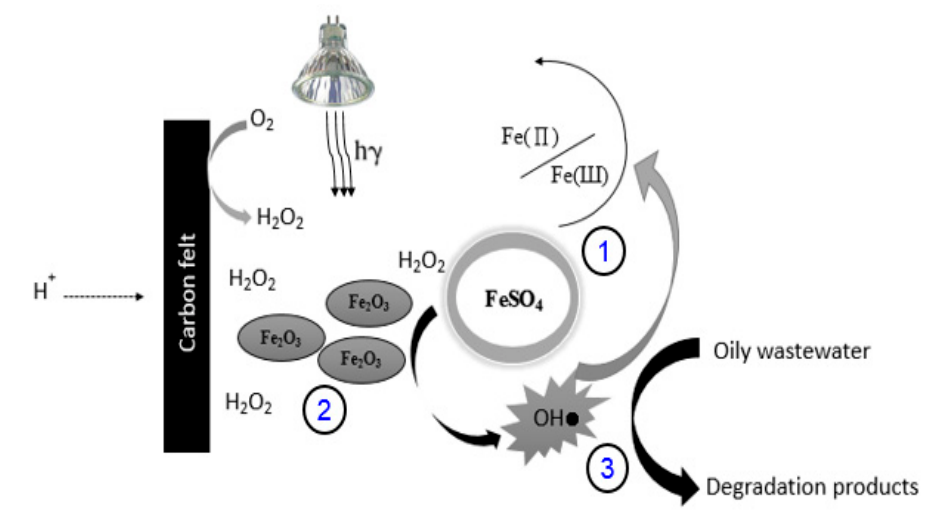
Figure 1. Proposed mechanism of Fe 2 O 3 /CF catalytic Bio-E-Fenton degradation of oily wastewater.